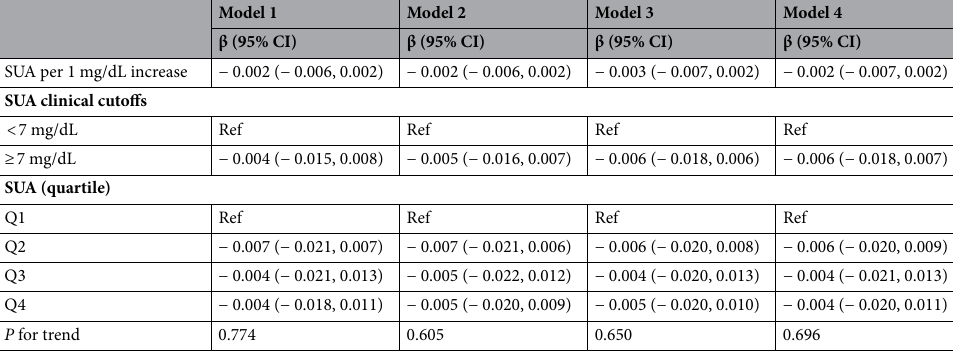
Table 3. Association between serum uric acid and lumbar bone mineral density among 6704 US adult males, weighted. Model 1 was adjusted for none. Model 2 was adjusted for age, race/ethnicity, education, physical activity, smoking and drinking. Model 3 was adjusted for all covariables in model 2 plus body mass index (BMI), calcium supplementation, energy intake, protein intake, serum calcium, serum phosphorus, 25-OH-D (1,25,D), parathyroid hormone, serum alkaline phosphatase (ALP), C-reactive protein (CRP), serum albumin and estimated glomerular filtration rate (eGFR). Model 4 was adjusted for age, race/ethnicity, smoking, BMI, serum albumin, eGFR, CRP, serum calcium, 1,25,D and calcium supplementation. The adjusted variables in model 4 were determined based on the change in effect of more than 10% when added to this model.